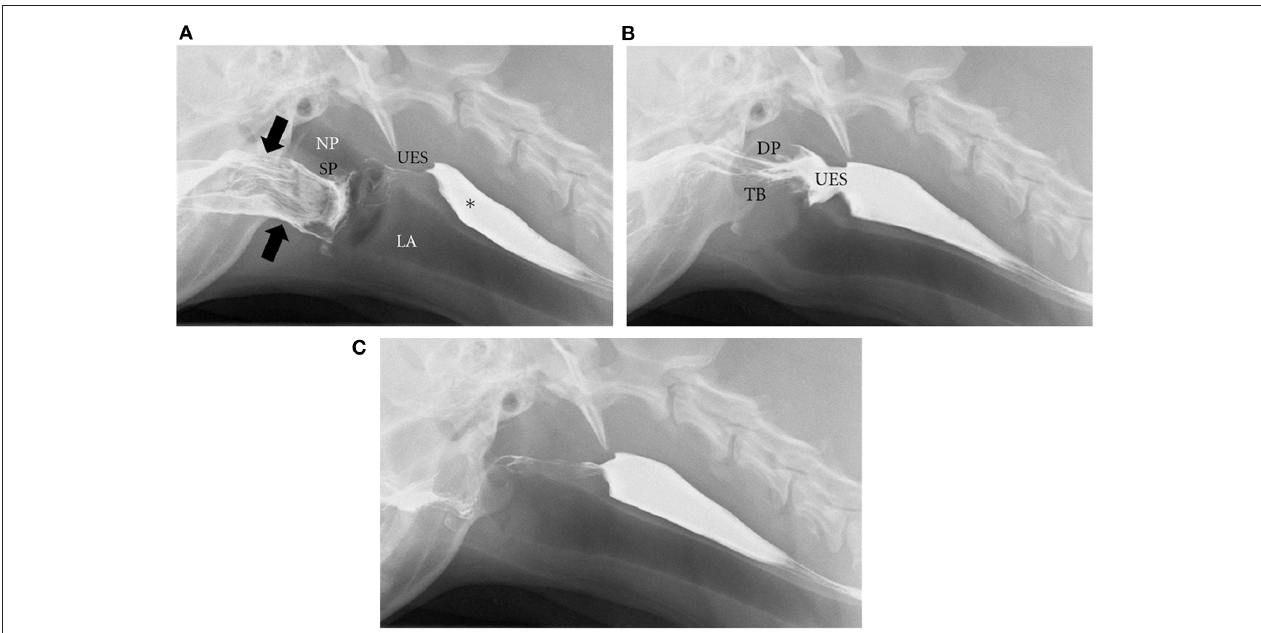
FIGURE 2 | Phases of deglutition. Digital images from a videofluoroscopic swallow study in a healthy dog show the phases of deglutition. (A) Oral phase: Liquid barium contrast in the oral cavity (designated by black arrows). There is also remaining barium from a previous swallow in the cervical esophagus (*). At the start of the pharyngeal phase, the soft palate will rise to close the nasopharynx while the epiglottis closes the larynx to prevent nasopharyngeal reflux and laryngeal penetration, respectively. NP, nasopharynx; LA, larynx; SP, soft palate; UES, upper esophageal sphincter. (B) As a continuation of the pharyngeal phase, the pharyngeal muscles contract and the dorsal pharyngeal wall (DP) meets the tongue base (TB) while the cricopharyngeus muscle relaxes to open the upper esophageal sphincter (UES). Liquid barium contrast can then pass through the open UES into the proximal esophagus. (C) After the contrast reaches the esophagus, esophageal peristalsis (primary and secondary) can occur to move the bolus through the lower esophageal sphincter (LES) to the stomach. (A–C) were reprinted from International Scholarly Research Network Veterinary Science, Volume 2012, Pollard RE, Imaging evaluation of dogs and cats with dysphagia, Copyright 2012 Rachel E. Pollard. Reprinted with permission from Dr. Rachel E